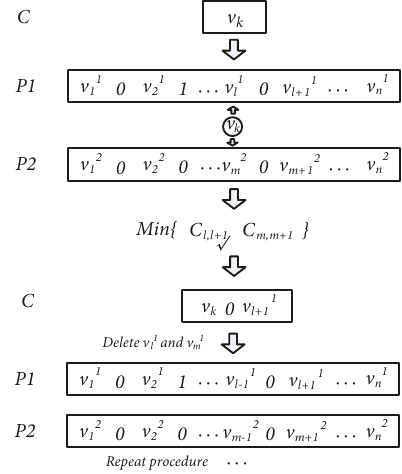
Figure 4: Crossover